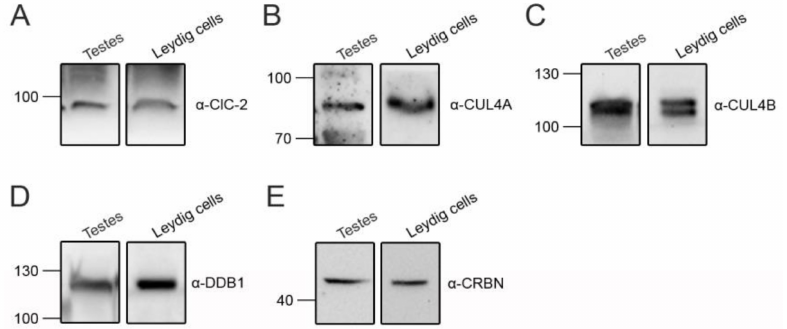
Figure 6. Endogenous expression of CUL4 E3 ligase in testes and Leydig cells. Representative immunoblots showing the endogenous expression of ClC-2 ( A ), CUL4A ( B ), CUL4B ( C ), DDB1 ( D ), and CRBN ( E ) in lysates prepared from mouse testes or cultured mouse Leydig cells. Approximately 30 µ g of protein was loaded into each